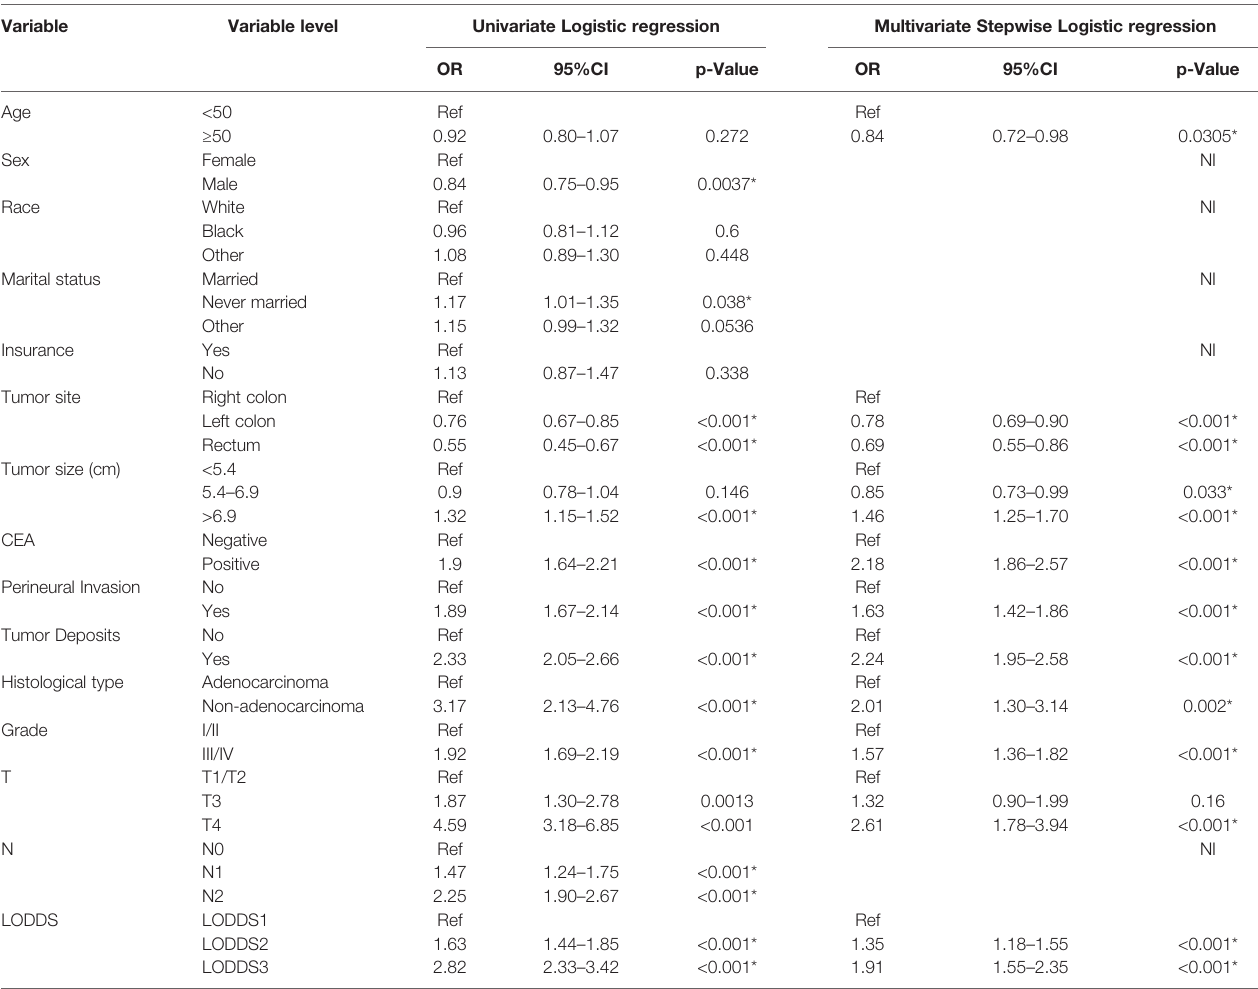
TABLE 2 | Univariate/Multivariate Logistic regression analyses of risk factors for multiple metastases in colorectal cancer. Variable Variable level Univariate Logistic regression Multivariate Stepwise Logistic